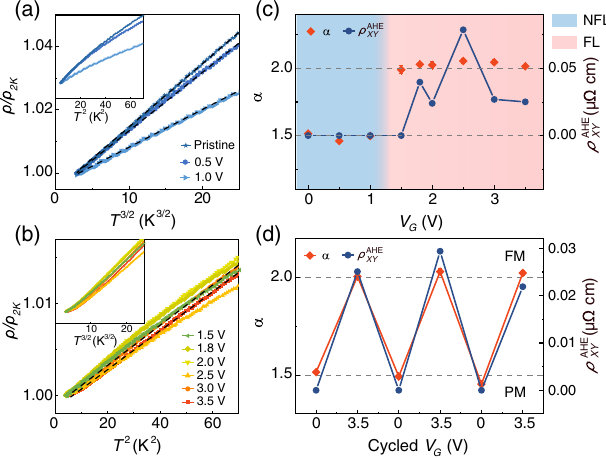
FIG. 3. Evolution from non-Fermi-liquid to Fermi-liquid behavior accompanied by magnetic transition. Normalized lon- 3 = 2 and (b) T 2 at ρ gitude resistivity ρ 2 K as a function of (a) T xx= low-temperature region with different V . Insets show the G > 1 . 0 V) deviation from T 2 ( T 3 = 2 ) for pristine (gated at V G states for comparison. The dashed lines are guides to the eyes. (c) Obtained fitting exponent α as a function of V for ρ ð T Þ ∼ T α , G forming two regions labeled by NFL and FL. The V dependence G of ρ AHE is also shown. (d) Reversible evolution of fitting XY exponent α and ρ AHE , as V cycled between 0 and 3.5 G XY